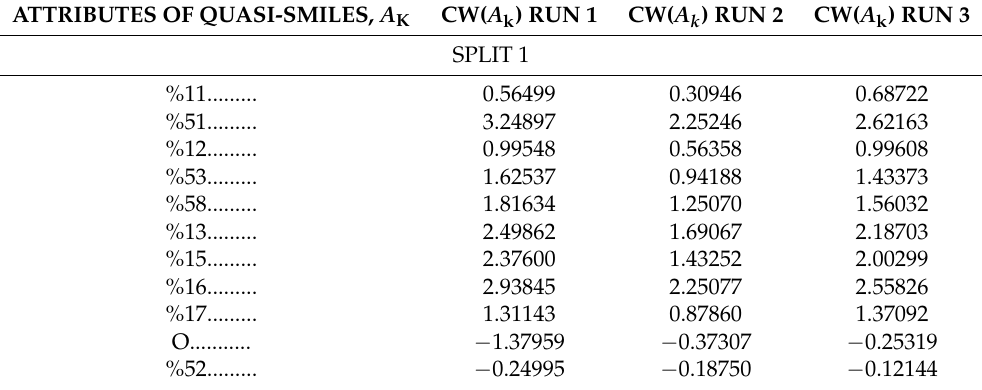
Table 5. Factors related to the increase (positives) of to the decrease (negatives) of zeta-potentials. ATTRIBUTES OF QUASI-SMILES, A